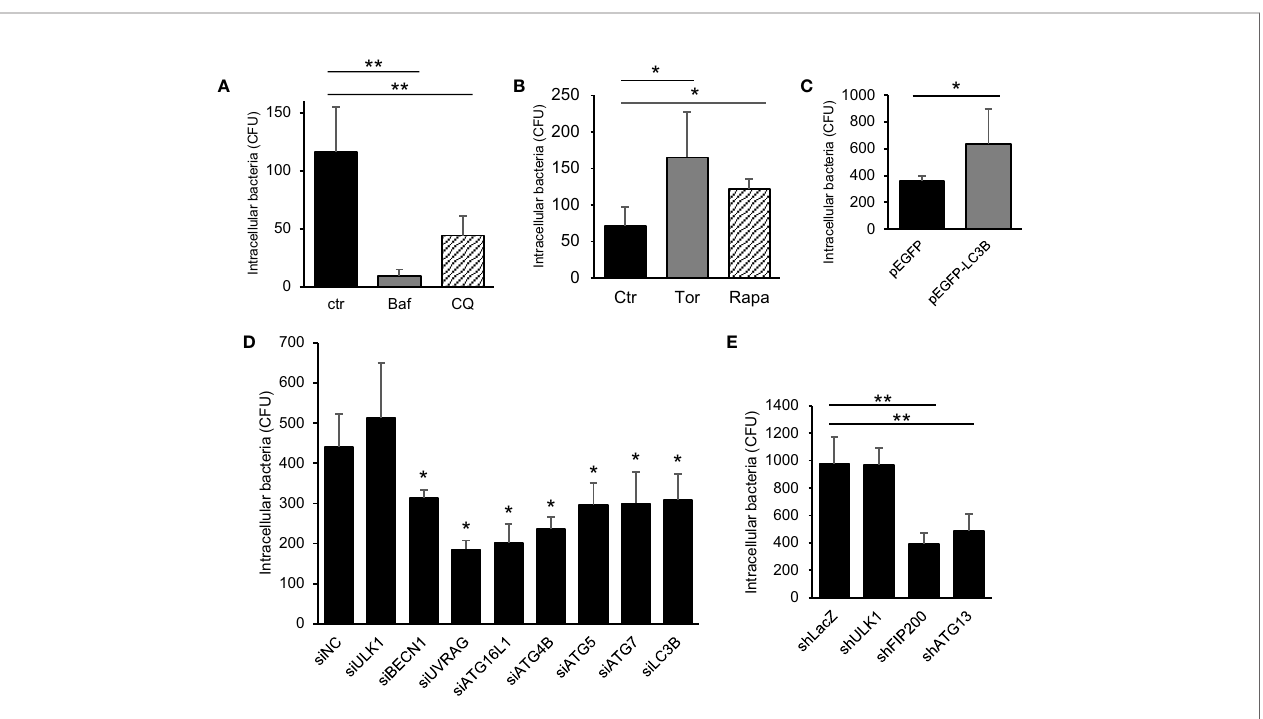
FIGURE 2 | The contribution of autophagy signaling in C. jejuni invasion step. (A) HeLa cells were treated with 200 nM Ba fi lomicin-A1 (Baf) or 50 m M Chloroquine (CQ) for 3 h. The number of intracellular C. jejuni was measured by gentamicin protection assay at 1 h p. i. , and decided by counting of Colony Forming Unit (CFU). (B) The number of intracellular C. jejuni in HeLa cells, which treated by 1 m M Torin 1 (Torin) or 200 nM Rapamycin (Rapa) for 3 h, were measured by gentamicin protection assay at 1 h p. i . (C) HeLa cells which stably express pEGFP or pEGFP-LC3B vector were infected with C. jejuni for 1 h, and the number of invaded bacteria was estimated by gentamicin protection assay. (D) siRNA against autophagy-related genes were transfected to HeLa cells, and intracellular bacterial number at 1 h p. i. was measured by gentamicin protection assay. (E) The expression of ULK1 complex components, ULK1, FIP200, and ATG13, were attenuated by shRNA-mediated knockdown in HeLa cells, and the invaded bacterial number was measured by gentamicin protection assay at 1 h p. i. All data are expressed as means ± standard deviations from 3 independent experiments. Differences were evaluated with Two-tailed Student ’ s t-test. * p < 0.05, ** p <